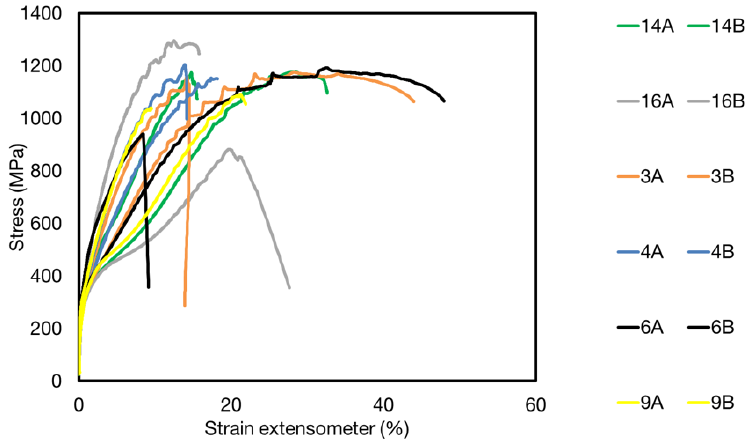
Figure 12. Engineering stress-strain diagrams of selected specimens: Ar shielded welds: weld 3—T15-82a + T15-82c (1650 W), weld 4—T15-82a + T15-82a (1650 W), weld 6—T15-82a + T15-82c (1650 W), weld 9—T15-81a + T15-82a; Not shielded welds: weld 14—T15-81a + T15-81a (1650 W), weld 16—T15-81a + T15-82a (1650 W), weld 19—T15-82a + T15-82c (1650 W).